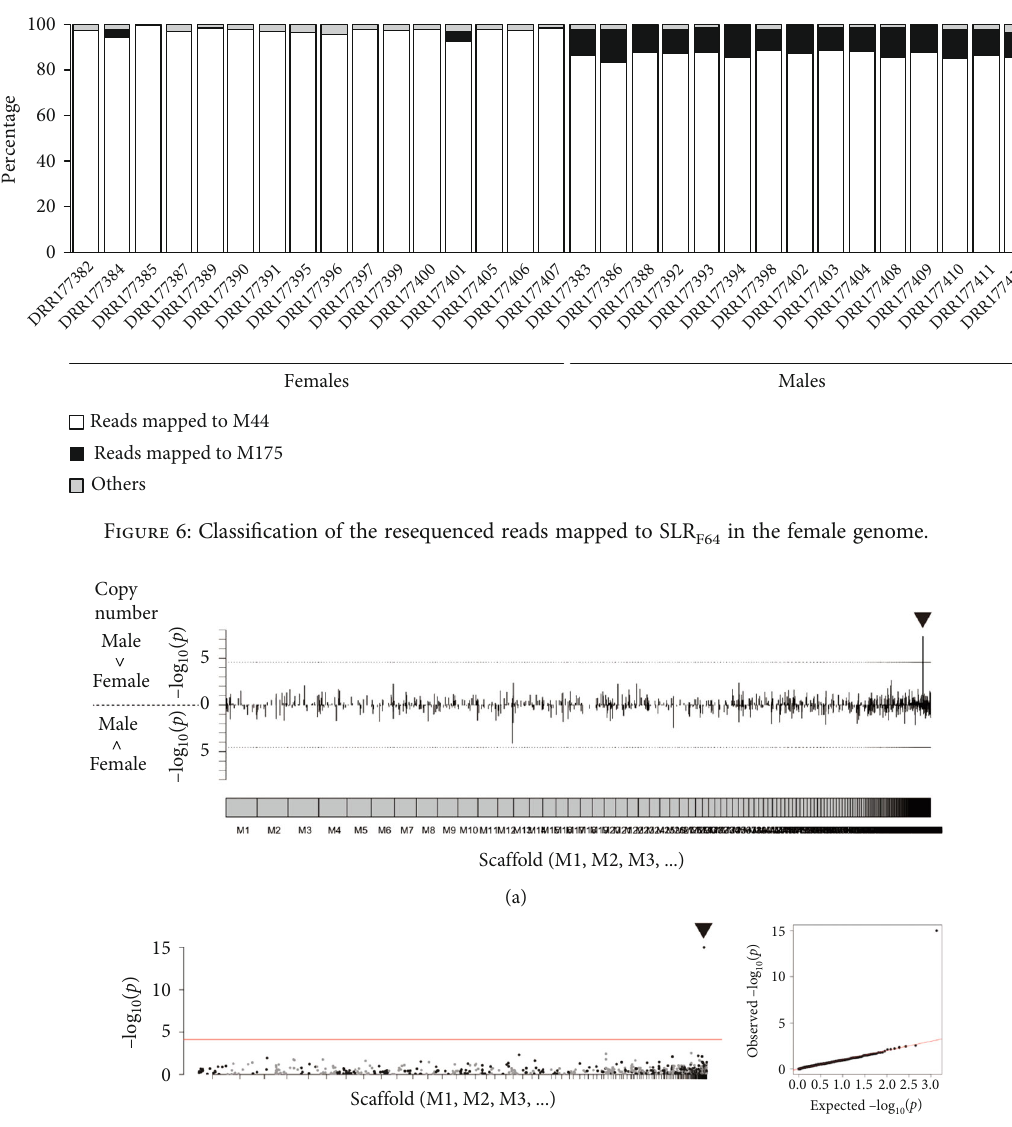
Figure 7: Genome-wide association with copy number between PBT males and females. The mapping of resequenced reads was conducted using a masked male reference. The plots on sca ff old M175 are indicated by triangles. (a) Di ff erences in regional copy number between ð P Þ in the Mann – Whitney U test. Upward plots indicate that the copy number is males and females are denoted as the values of − log 10 larger in males than in females, while downward plots indicate the inverse. Genome-wide signi fi cance cuto ff s based on Bonferroni correction are indicated by dashed lines. (b) Manhattan plot (left) and Q-Q plot (right) from CNV-based GWA scan. The regions with copy number 0, 0.5, or 1 were selected ( P values lower than 10 -15 were treated as 10 -15 ). In the Manhattan plot, genome-wide signi fi cance cuto ff based on Bonferroni ’ s correction is indicated by a red